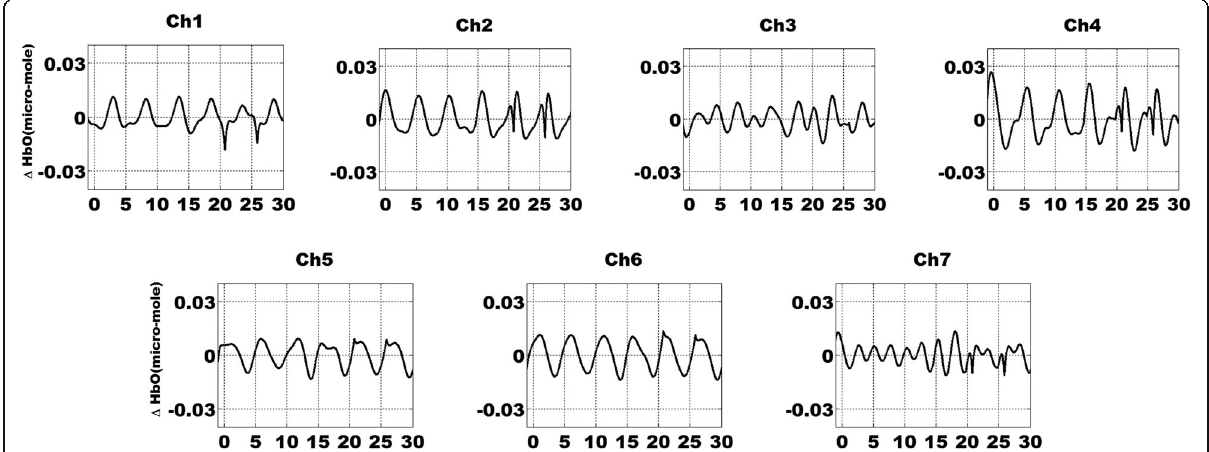
Fig. 6 The time-domain of HbO signals after deconvolution during periodic FE stimuli with SSVEP. The time course of fNIRS data is grand- averaged across all conditions and participants. The unit of the x -axis is seconds while the unit of the y -axis is